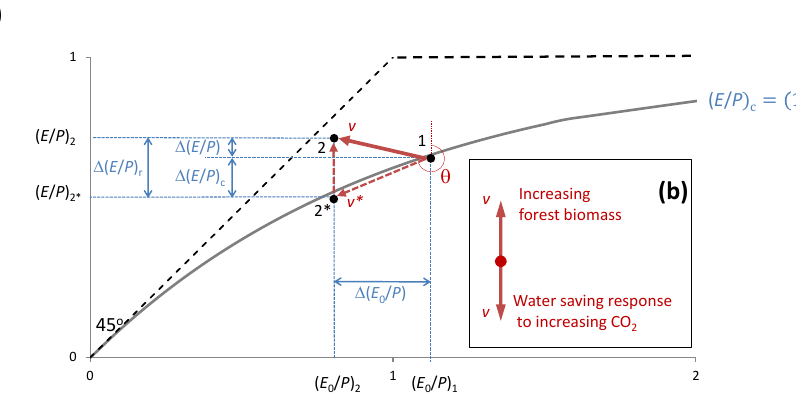
Figure 2. Schematic representation of movement in Budyko space. (a) Evaporative ratio ( E/P ) vs. aridity index ( E 0 /P ) and the parameters describing movement in such space from period 1 ( t 1 ) to period 2 ( t 2 ) by a vector ( v ). The t 1 and t 2 represent mean conditions of E/P and E 0 /P during the periods 1961–1986 and 1987–2012, respectively. The change in evaporative ratio ( (cid:49)E/P) is divided into an effect from changes in the aridity index, (cid:49)(E/P) c , termed the climatic effect and represented by the vector ( v ∗ ), and an effect from other drivers, termed the residual effect, (cid:49)(E/P) r . The elliptic curve describes the Budyko-shaped curve of Choudhury’s relationship between E/P and E 0 /P . (b) The expected directions of movements in Budyko space with fixed E 0 /P for increasing forest standing biomass and water-saving response to increasing atmospheric CO 2 concentrations under constant